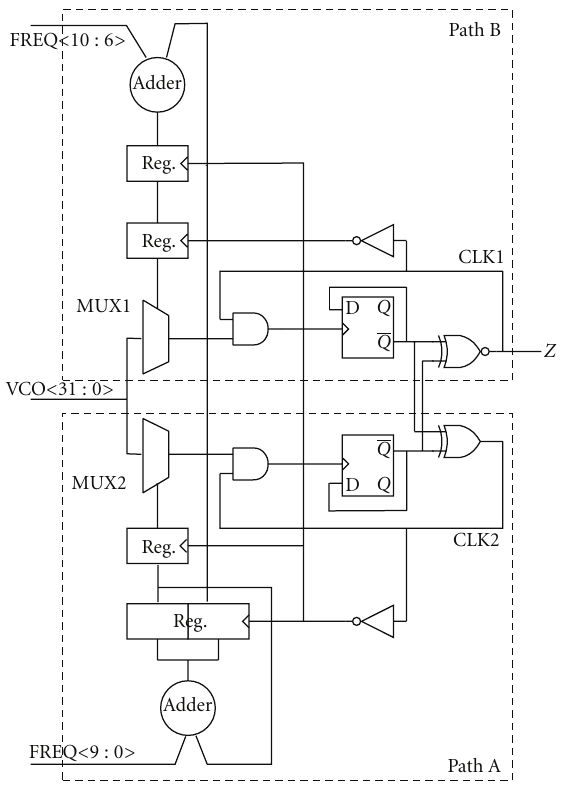
Figure 3: Two-path flying-adder frequency synthesizer